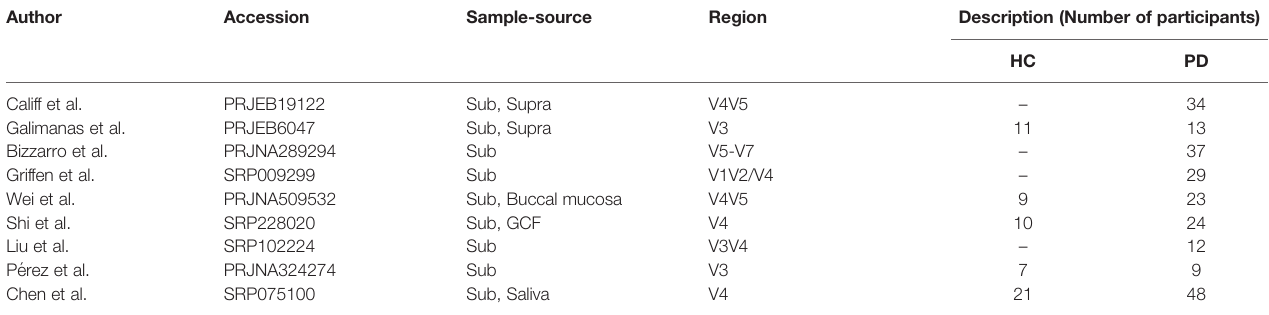
TABLE 1 | Summary of the studies included in pooled